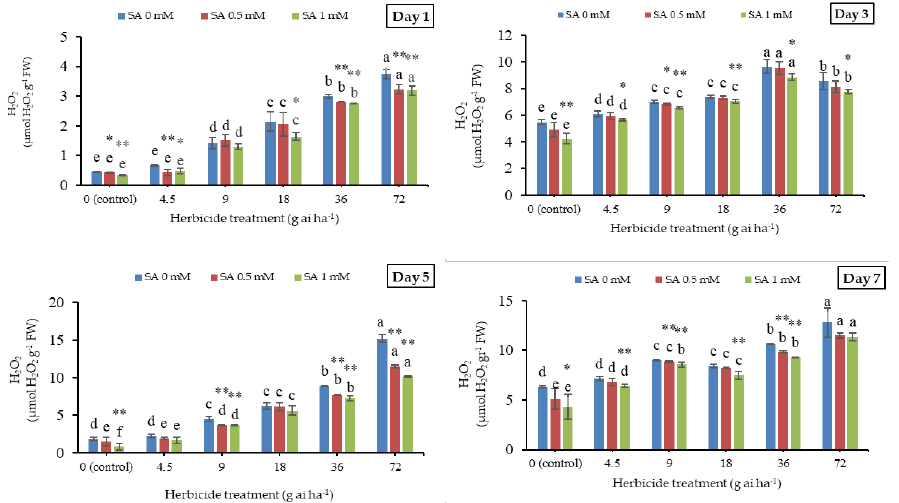
Figure 2. Changes in hydrogen peroxide (H 2 O 2 ) content in the leaf tissues of wheat at 1, 3, 5, and 7 days after herbicide application at different rates. The leaves were pre-treated with different concentration of salicylic acid (SA) 3 days prior to herbicide application. The bars represent the treatment mean ± SD ( n = 4), and the bars with different lower-case letters were significantly ( p ≤ 0.05) different according to the Duncan’s test. Asterisks indicate significant difference between the herbicide only and herbicide with each concentration of SA, according to the Independent Samples t -test.